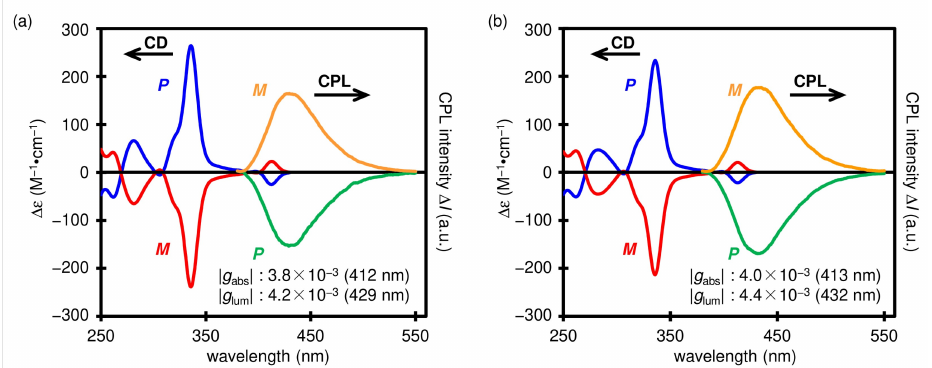
Figure 5. CD (in CH 2 Cl 2 ) and CPL (in 2-Me-THF) spectra of ( a ) 5b and ( b ) 5c . The g abs and g lum values were calculated at the longest CD maximum and the CPL maximum, respectively. Wavelength for the calculated values in